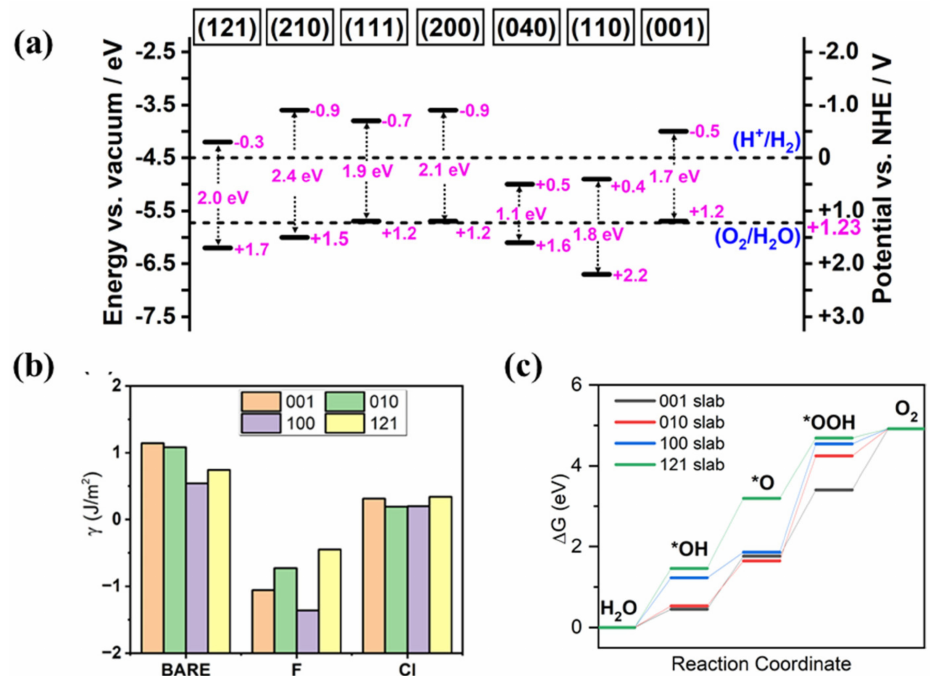
Figure 5. ( a ) VBM and CBM energy levels for the optimized (121) − , (210) − , (111) − , (200) − , (040) − , (110), and (001) oriented α -SnWO 4 slabs [61,63]; ( b ) surface free energy ( γ ) of facets before and after the termination with F and Cl atoms; ( c ) free-energy profiles of OER on (001) − , (010) − , (100) − , and (121) slabs at 0 V (the * means adsorbed state)